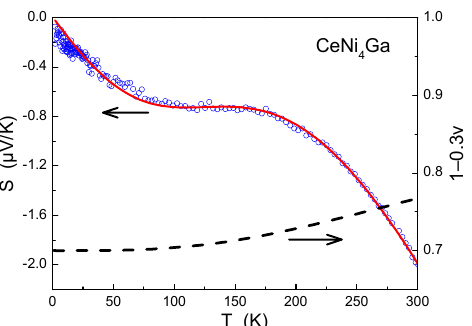
Figure 6. Left axis: Thermoelectric power S ( T ) of CeNi 4 Ga fitted with Equation (5). See the text for the values of the parameters. Right axis: Occupancy of the f states as a function of temperature.